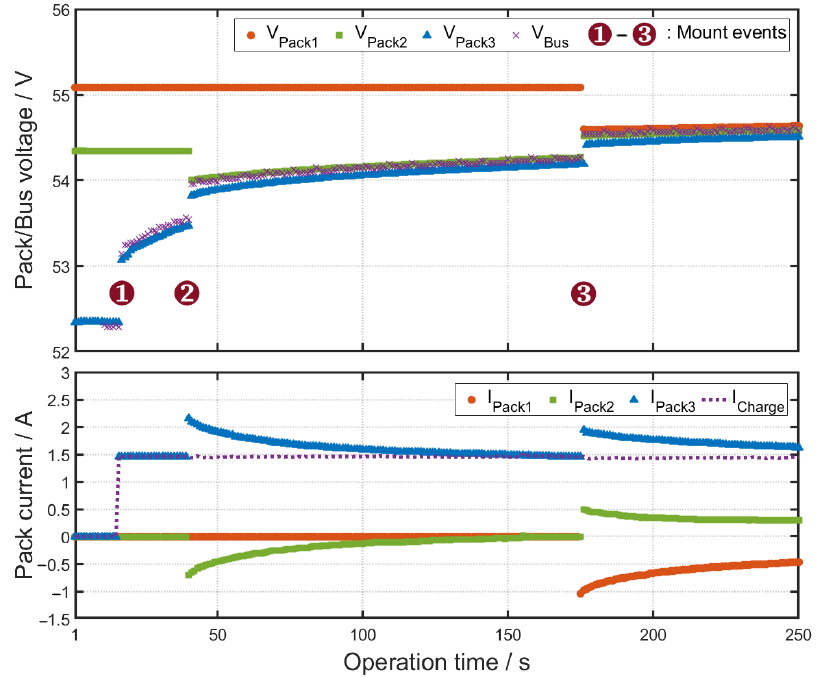
Figure 9. Enlarged view of the sequential mounting events at the initiation of the battery pack charging cycle.